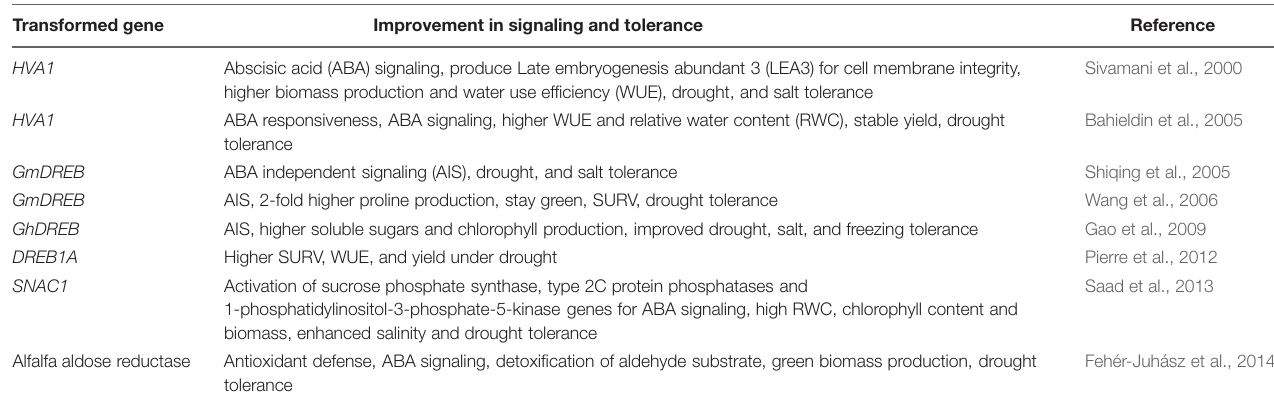
TABLE 2 | Improvement in wheat drought signaling and tolerance by transgenic approaches. Transformed